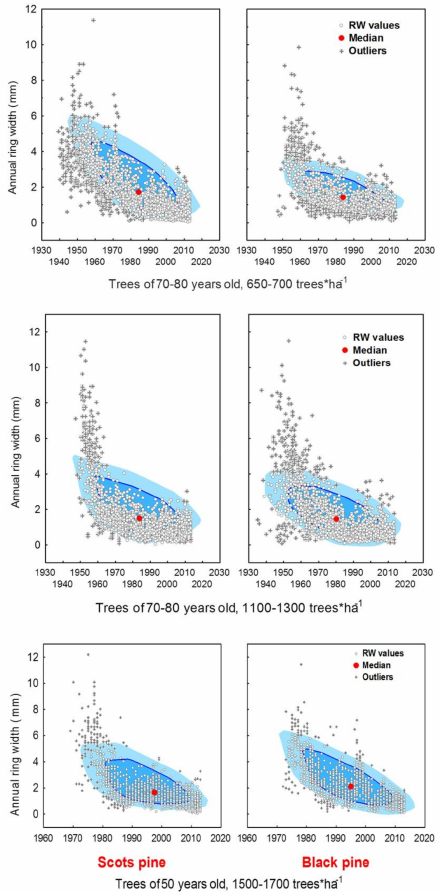
Figure 4. Ring width dynamic: comparisons between the black pine and the Scots pine for densities